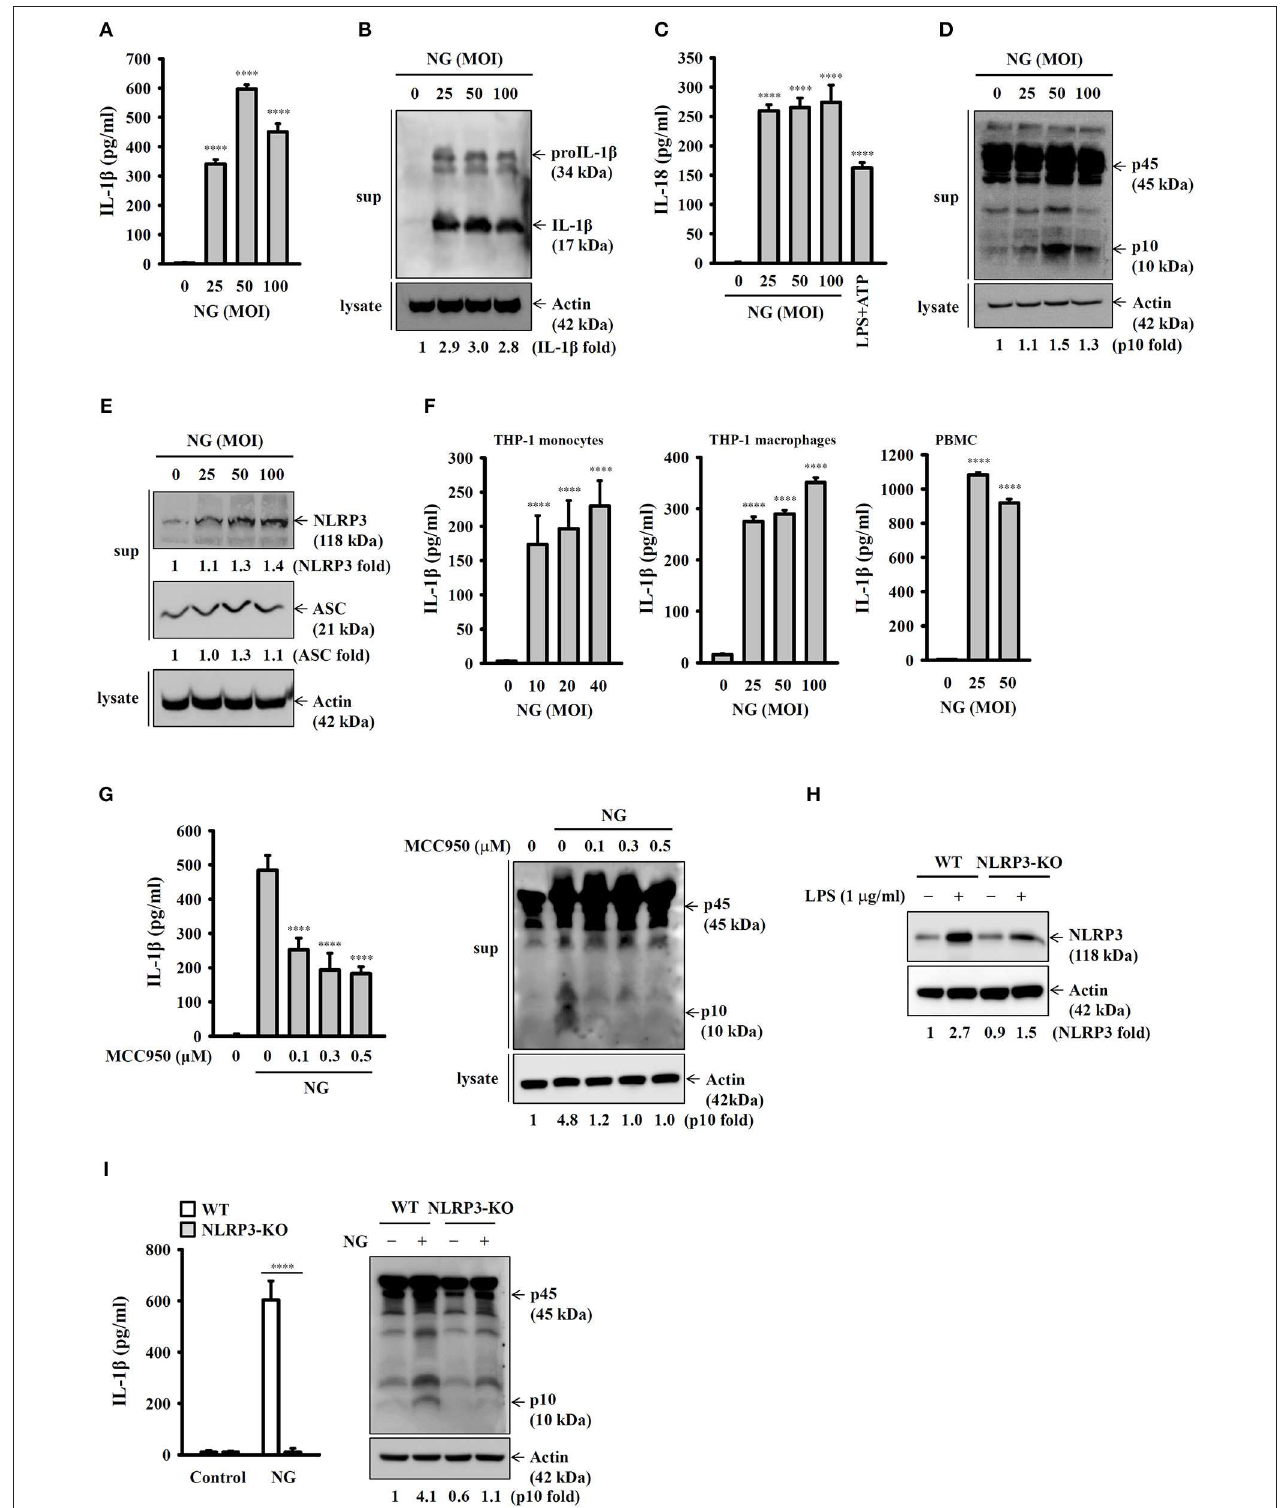
FIGURE 1 | NG infection activates the NLRP3 inflammasome in mouse and human macrophages. (A–E) J774A.1 macrophages were infected for 24h with NG. The levels of IL-1 β and IL-18 in the supernatants were measured by ELISA (A,C) , and the levels of proIL-1 β /IL-1 β (B) , p45/p10 (D) , and NLRP3/ASC (E) in